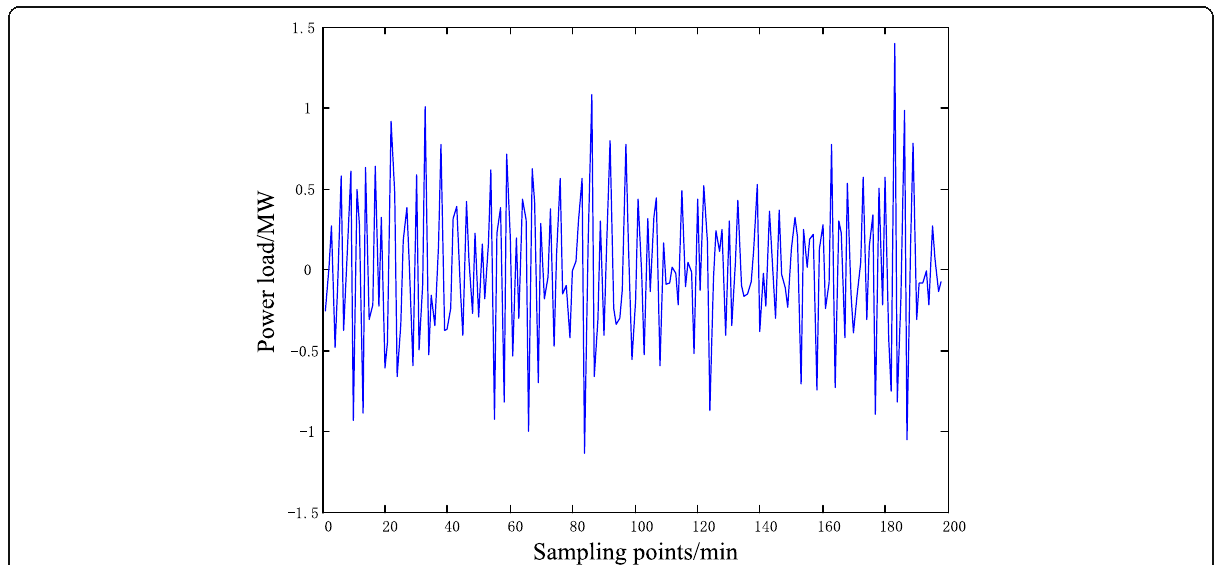
Fig. 2 Stochastic noise of electric power load after one-order differential